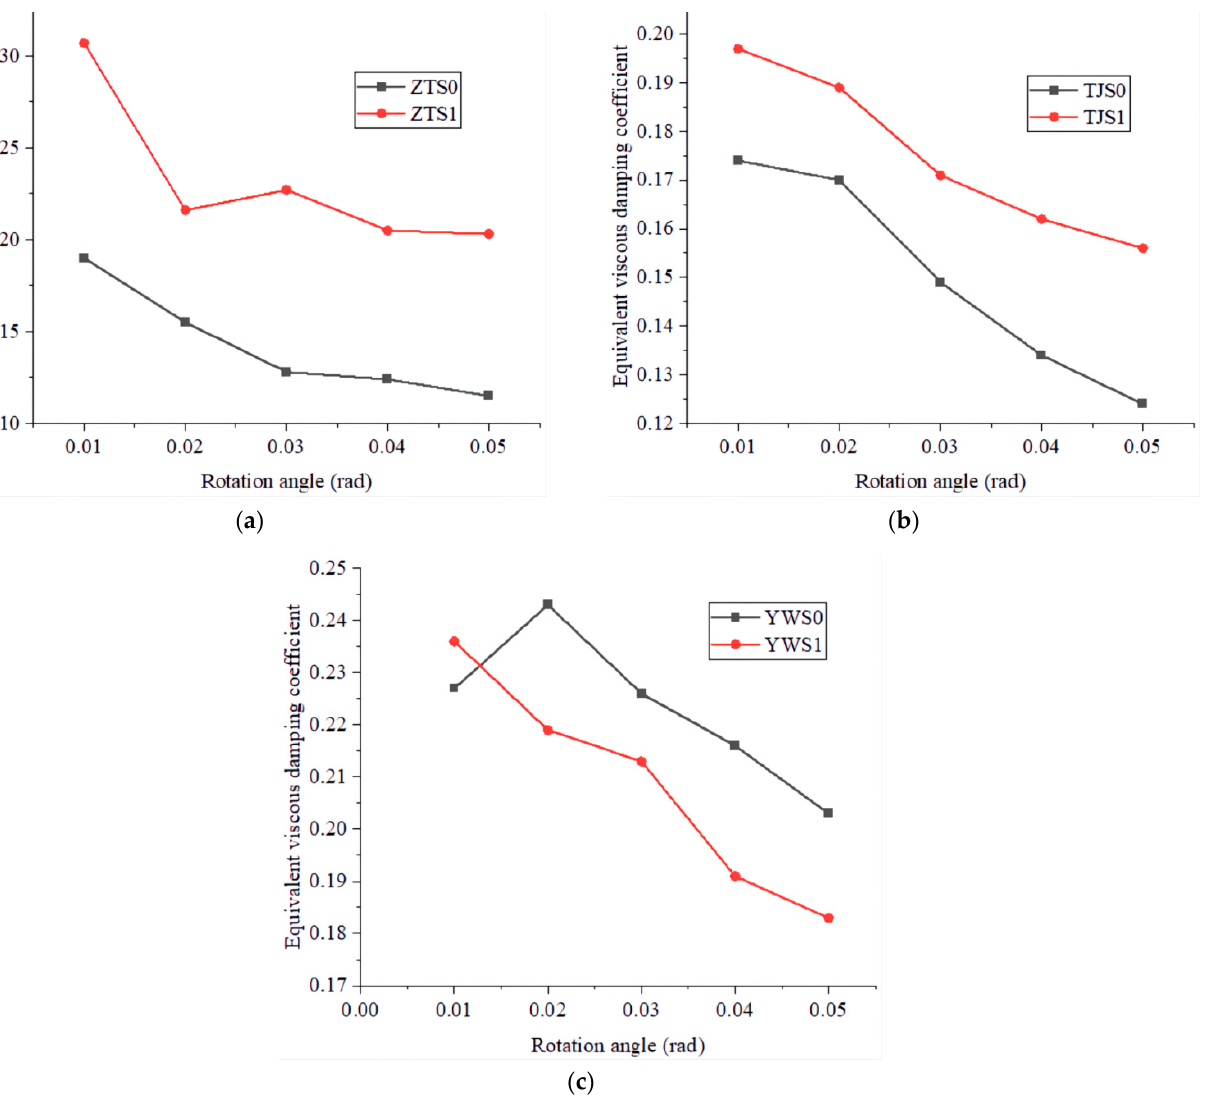
Figure 13. Relationship between equivalent viscous damping coefficients and rotation angles of samples before and after reinforcement: ( a ) Straight tenon; ( b ) Penetrated tenon; ( c ) Dovetail tenon.